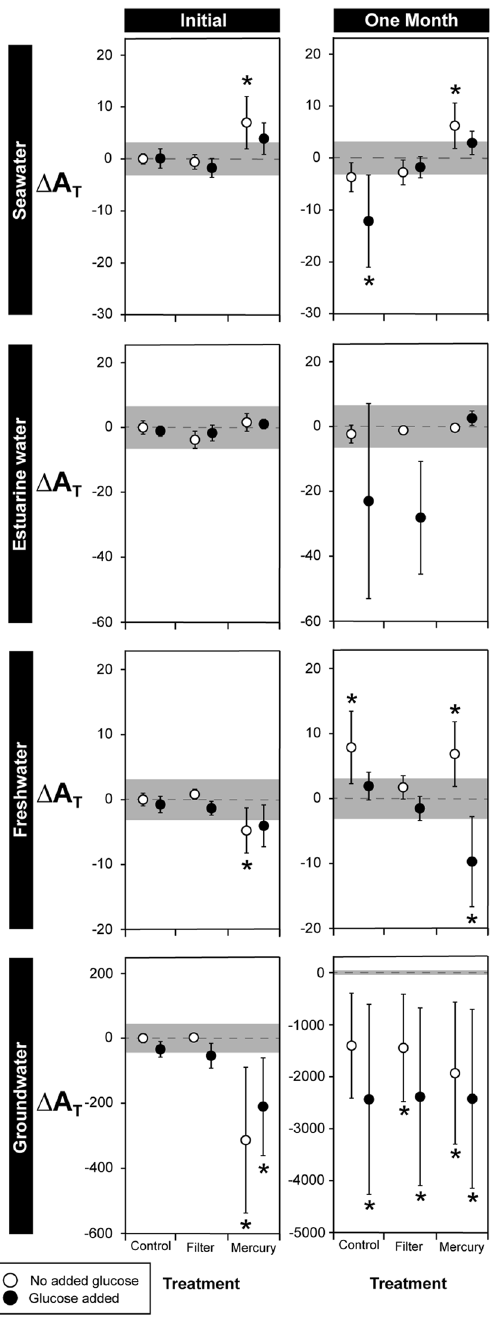
Figure 3. The effects of glucose addition and preservation method on difference in total alkalinity (∆A T ) of seawater, estuarine water, freshwater, and groundwater samples stored for 0 and 1 month. All results represent the difference between observations and the mean A T of untreated samples measured at the beginning of the experiment (A T values of benchmark controls are shown in Table 1). Water samples were treated using one of three methods (no treatment; 0.45 µm filter; 100 µL saturated HgCl 2 solution (25 °C)), and had a concentrated glucose solution added (black) or no glucose added (white). Addition of the glucose solution increased dissolved organic carbon (DOC) by ~ 10–15 times compared to ambient levels (Supplementary Information Table S1). Samples were stored in polypropylene vials at 4 °C for 0 or 1 month. Shaded areas on graphs represent ± 2 standard deviations of the respective benchmark control (Table 1). Asterisks indicate there was a significant difference in A T of samples in a treatment compared to the A T of the benchmark control according to Dunnett’s tests, and should not be used to evaluate statistical difference or similarity among treatments. Data are means ± 1 standard deviation. n = 5. Note: scale of Y axes differs for groundwater initial and 1